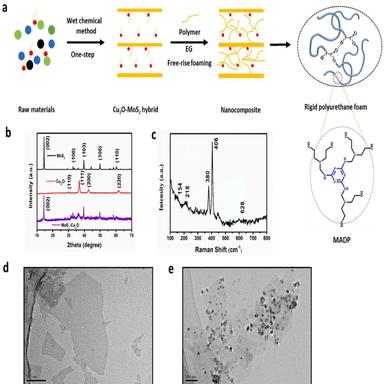
Schematic presentation of the formation mechanism of the M-RPUF/EG/MoS2-Cu2O nanocomposite (a); XRD patterns of the MoS2, Cu2O and MoS2-Cu2O nanohybrid (b) and Raman spectrum of MoS2-Cu2O nanohybrid (c); TEM images of MoS2 (d) and MoS2-Cu2O nanohybrid (e).